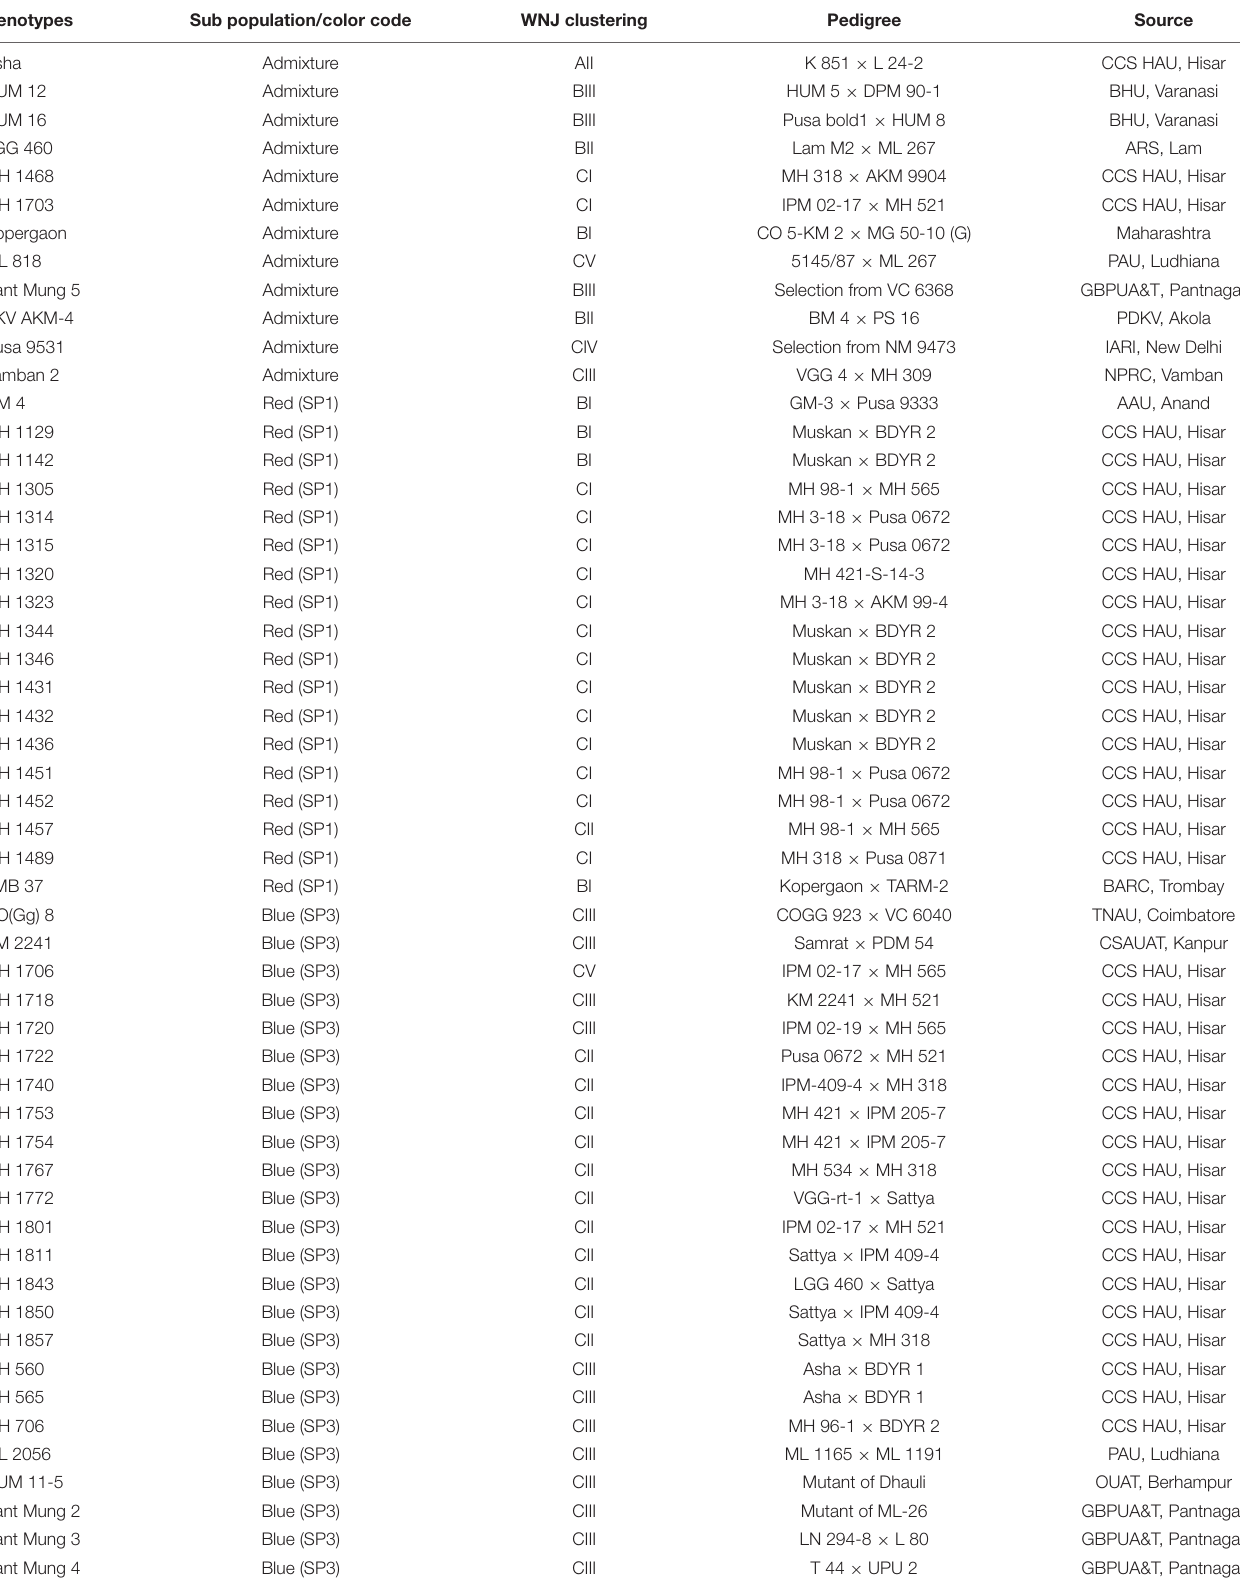
TABLE 3 | Grouping of released and advanced breeding lines based on weighted neighbor-joining and population genetic structure. Genotypes Sub population/color